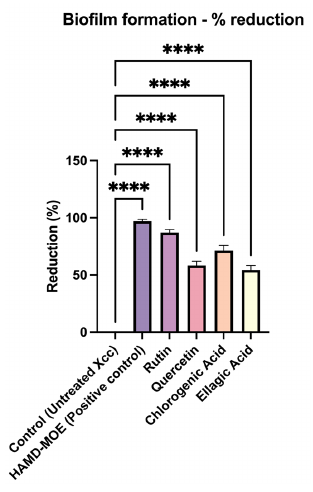
Figure 2. In vitro biofilm formation assay. X. campestris pv. campestris biofilm formation was assessed with the crystal violet method, presented as a percentage compared to untreated control. Data represent the average of three independent experiments on three copies (mean ± standard deviation), and values are given as percentages; **** p < 0.001. The analysis performed on the activity of single strains can be found in Supplementary Figure S2.